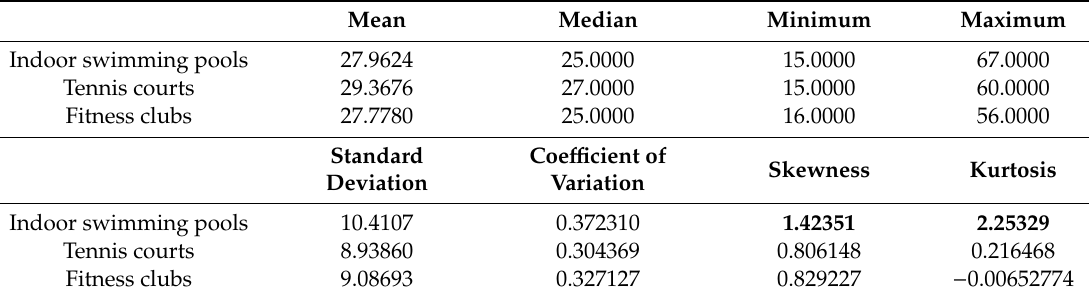
Table 4. Descriptive statistics for observations from sample n = 1159 for the age variable in each object.